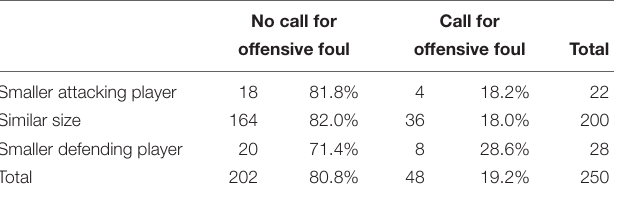
TABLE 5 | Frequency of calls for an offensive foul by body composition differences.